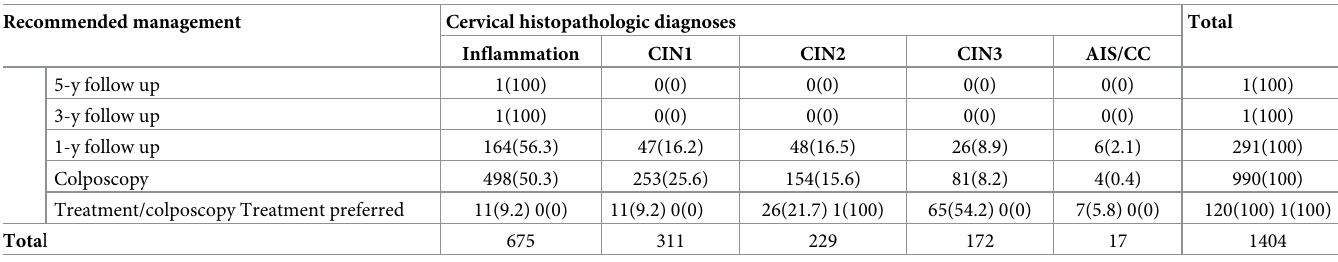
Table 5. Agreement between recommended management according to the 2019 ASCCP guidelines and final cervical histopathologic diagnoses (%). Recommended